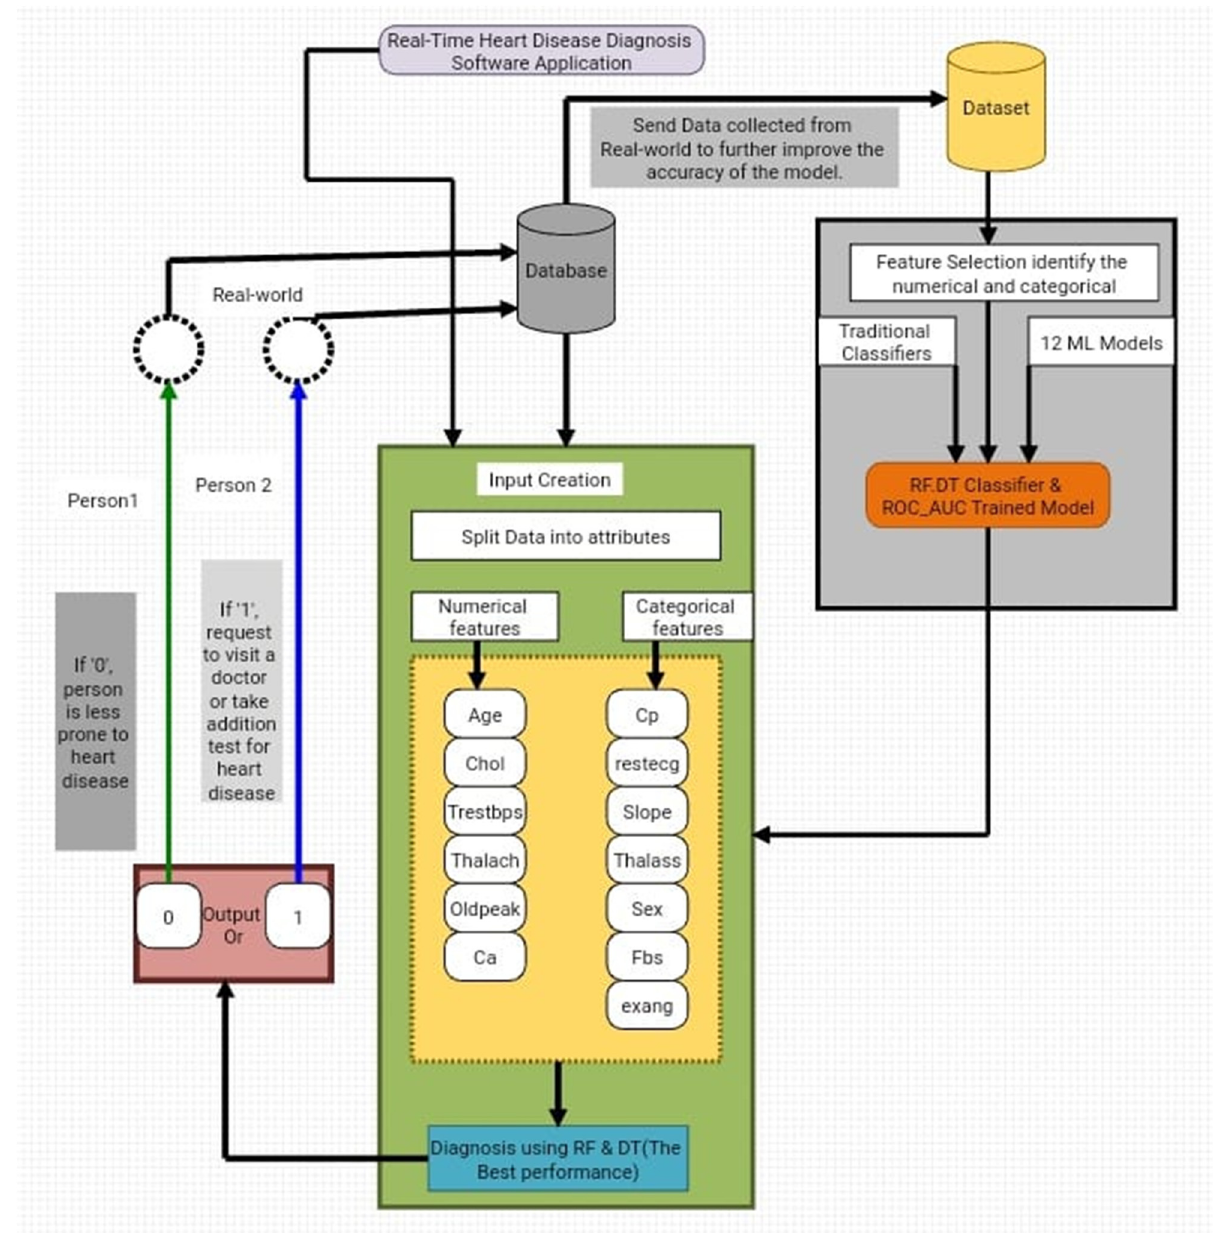
Figure 4. Application of proposed model.